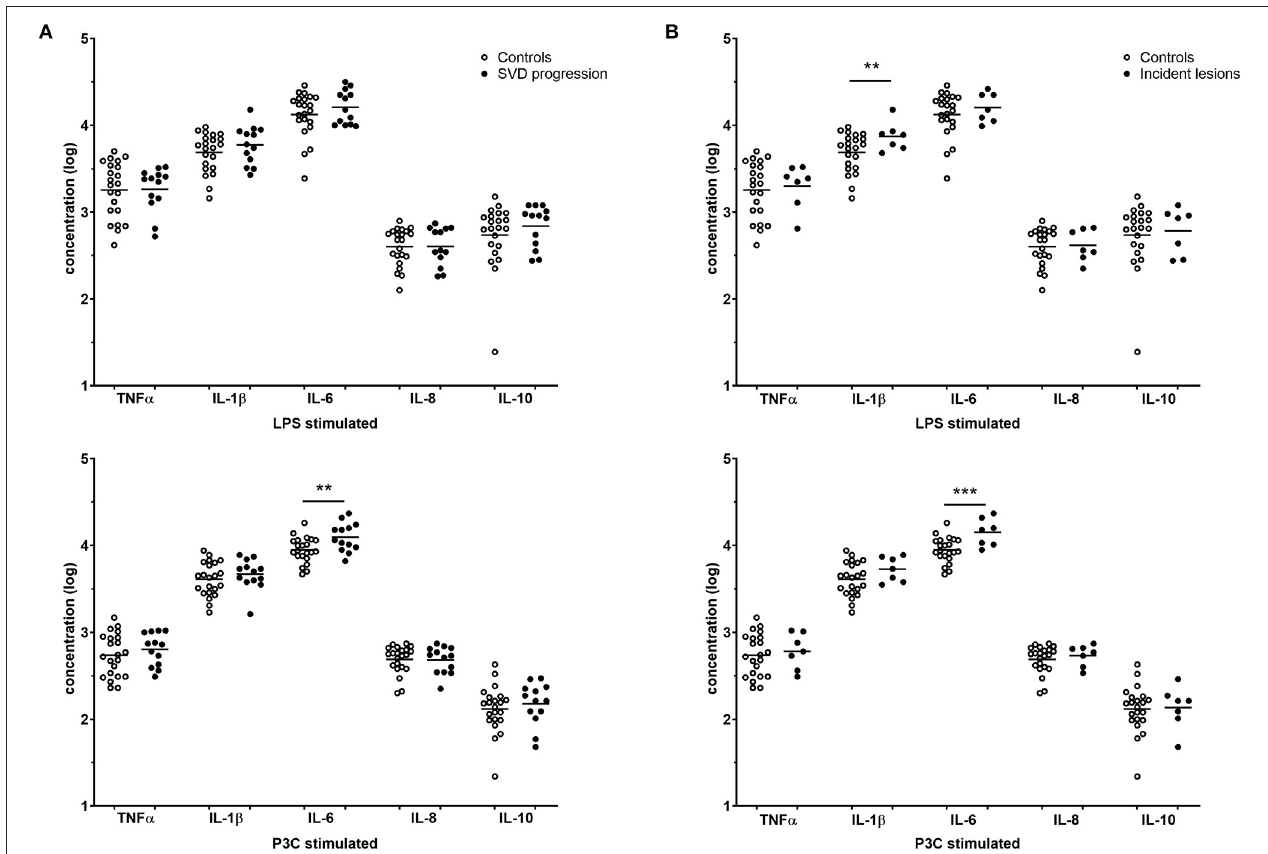
FIGURE 2 | Cytokine production capacity. Cytokine responses of participants without SVD progression (white, n = 22), (A) participants with SVD progression (gray, n = 13) and (B) incident lesions (gray, n = 7) are reported as individual points with mean on log-transformed data. P -values are corrected for age, sex, and hypertension with ANCOVA. ** P < 0.01, *** P = 0.001. SVD, small vessel disease.